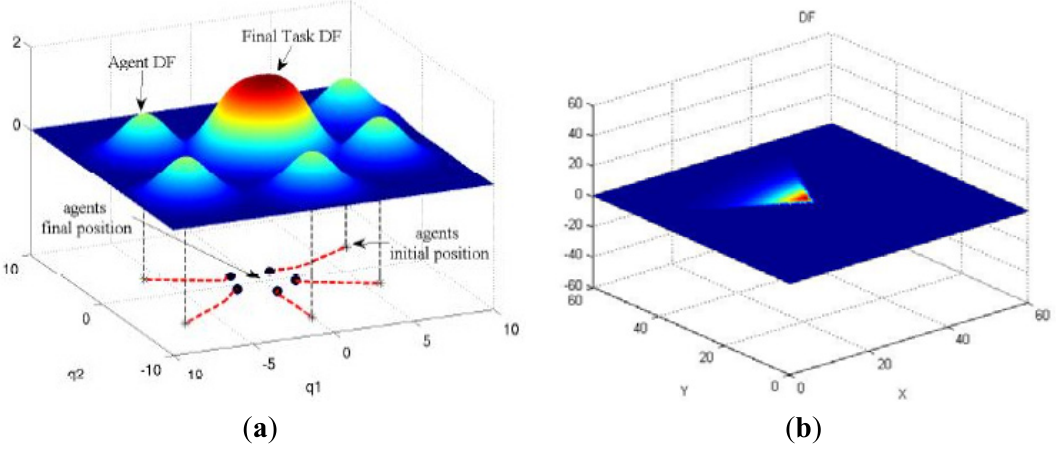
Figure 1. Example of Descriptor Function Framework: Gaussian ( a ), Limited ( b